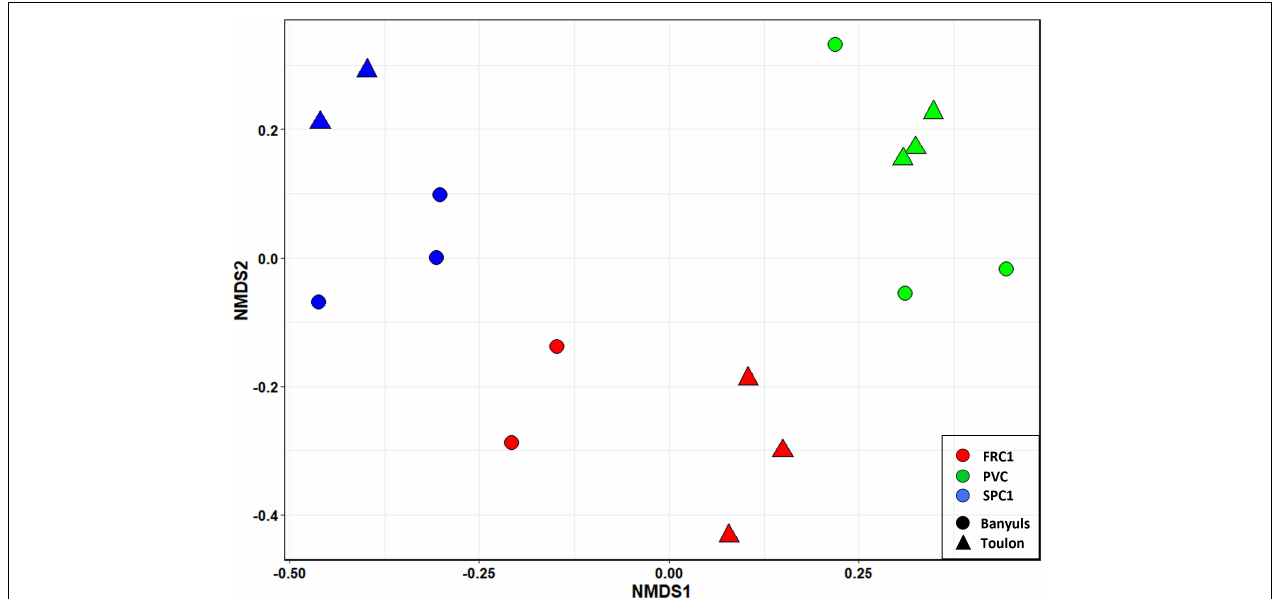
FIGURE 5 | NMDS of the prokaryotic communities on the three substrates in triplicates (PVC, FRC1, and SPC) after 75 days of immersion at Toulon and Banyuls.